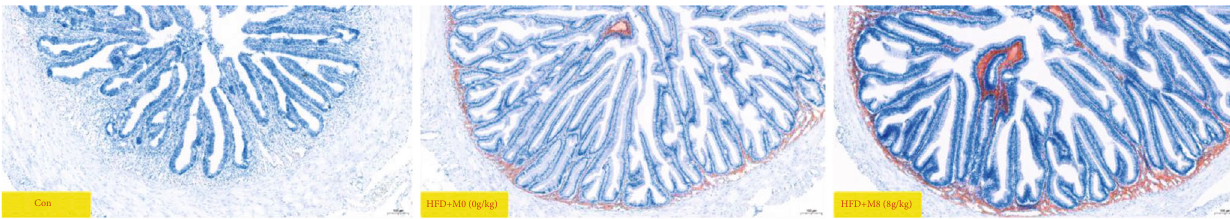
Figure 3: E ff ects of high-fat diet supplemented methionine on the intestinal oil red O stained sections ( ×